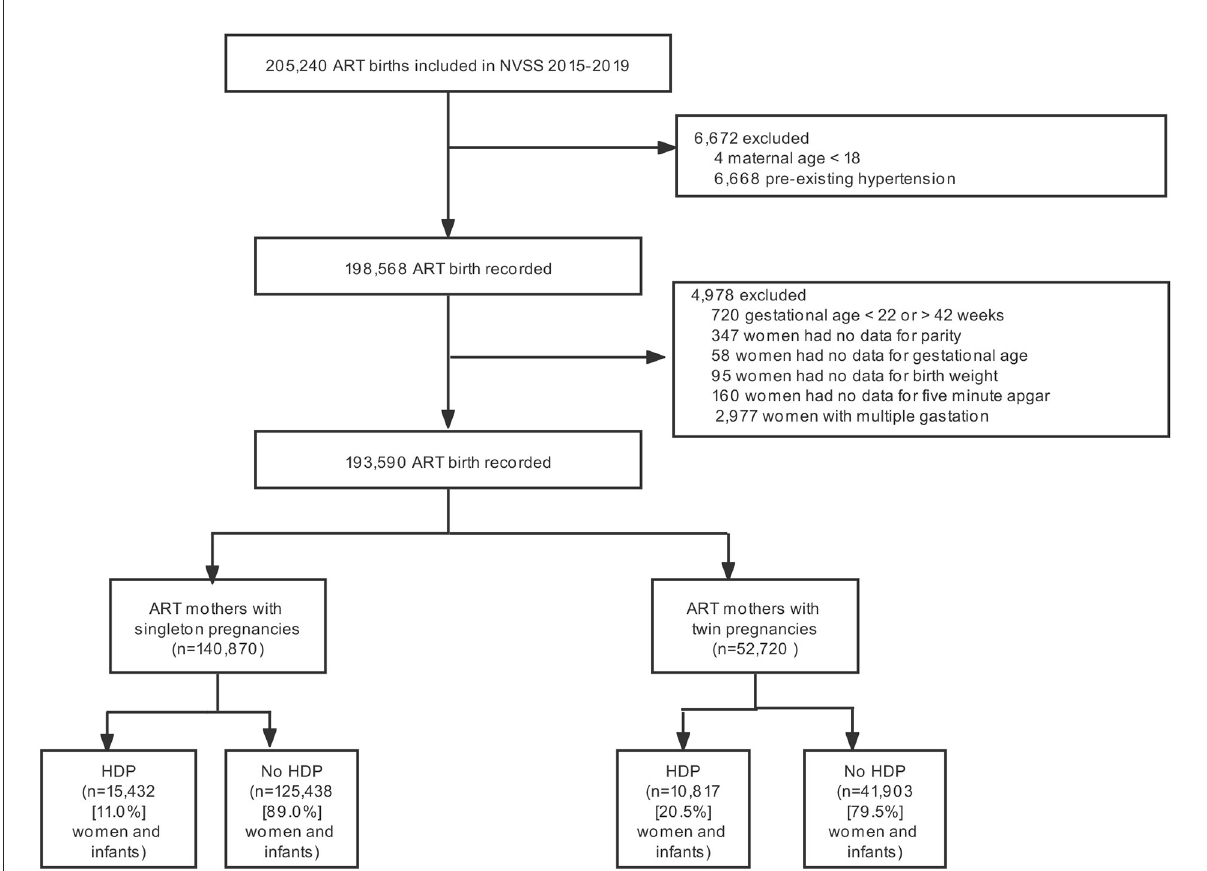
FIGURE1 Participant flow chart. NVSS, US National Vital Statistics System; ART, Assisted reproductive technology; HDP, Hypertensive disorders of